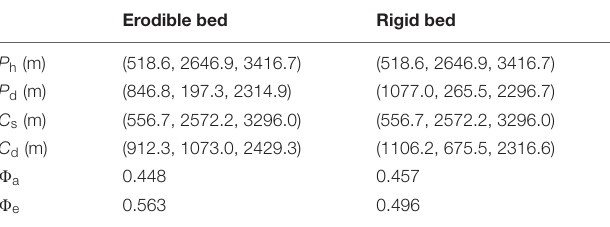
TABLE 2 | Kinematic parameters of simulation results in different substrate conditions. Erodible bed Rigid